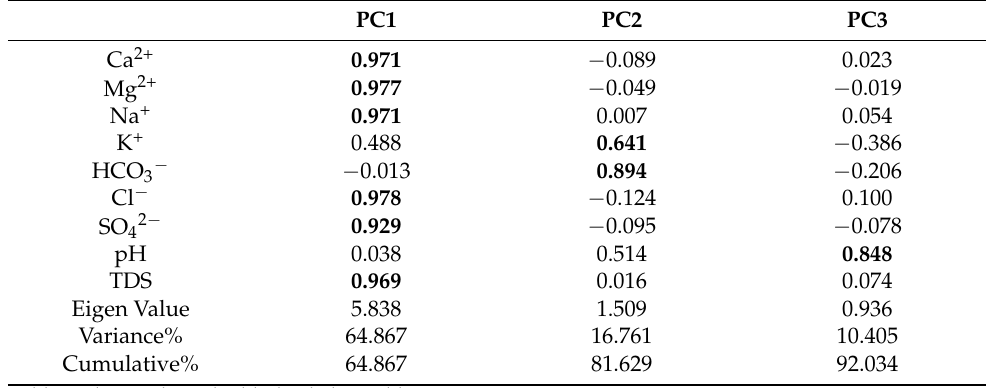
Table 3. Variables of the principal component analysis for the studied groundwater.